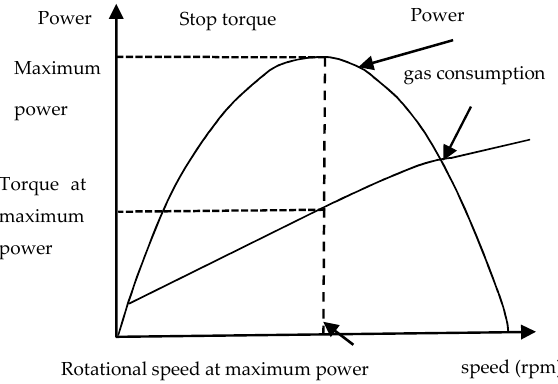
Figure 1. Power characteristic curve of the pneumatic motor.